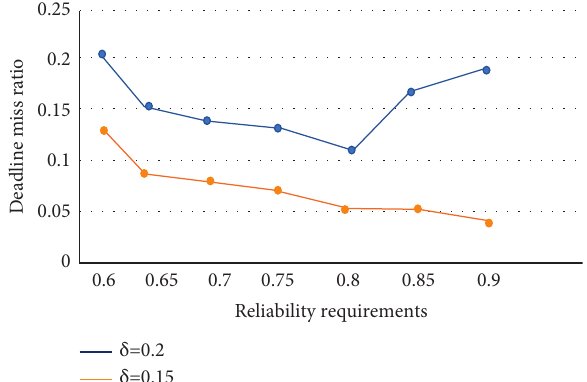
Figure 11: Comparison of deadline miss ratio under different reliability